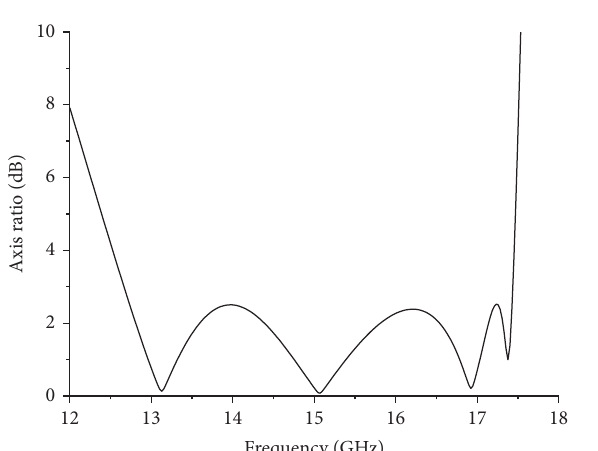
Figure 14: The calculated axial ratio.